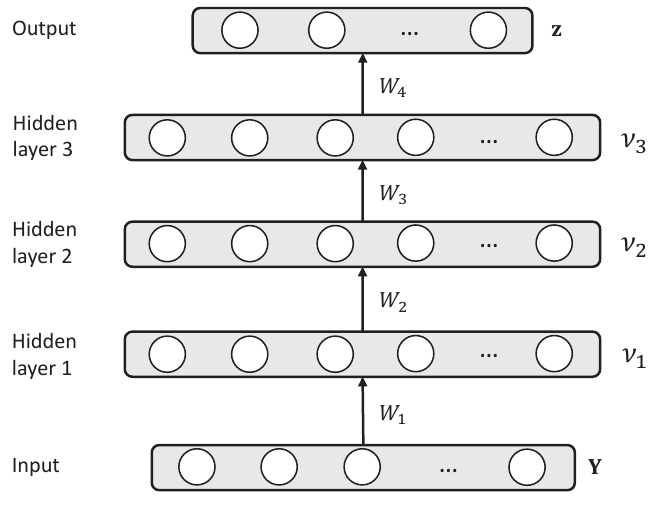
Figure 3. The architecture of